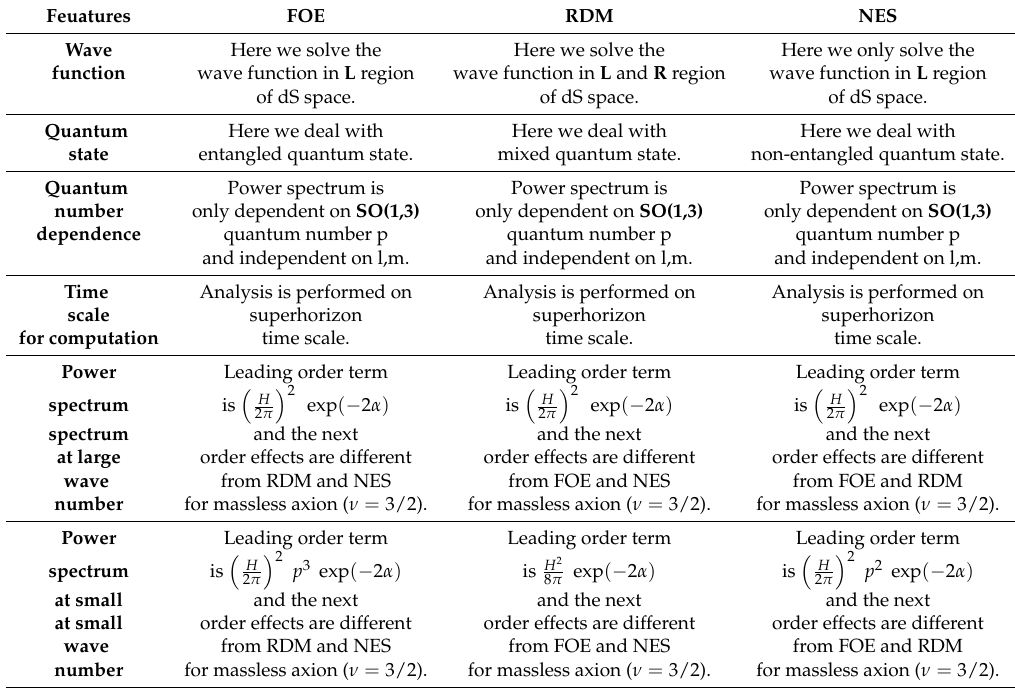
Table 1. Comparison between FOE, RDM and NES formalism for α vacua. Feuatures Here we only solve the function wave function in L and R region wave function in L region of dS space. of dS space. of dS space. mixed quantum state. non-entangled quantum